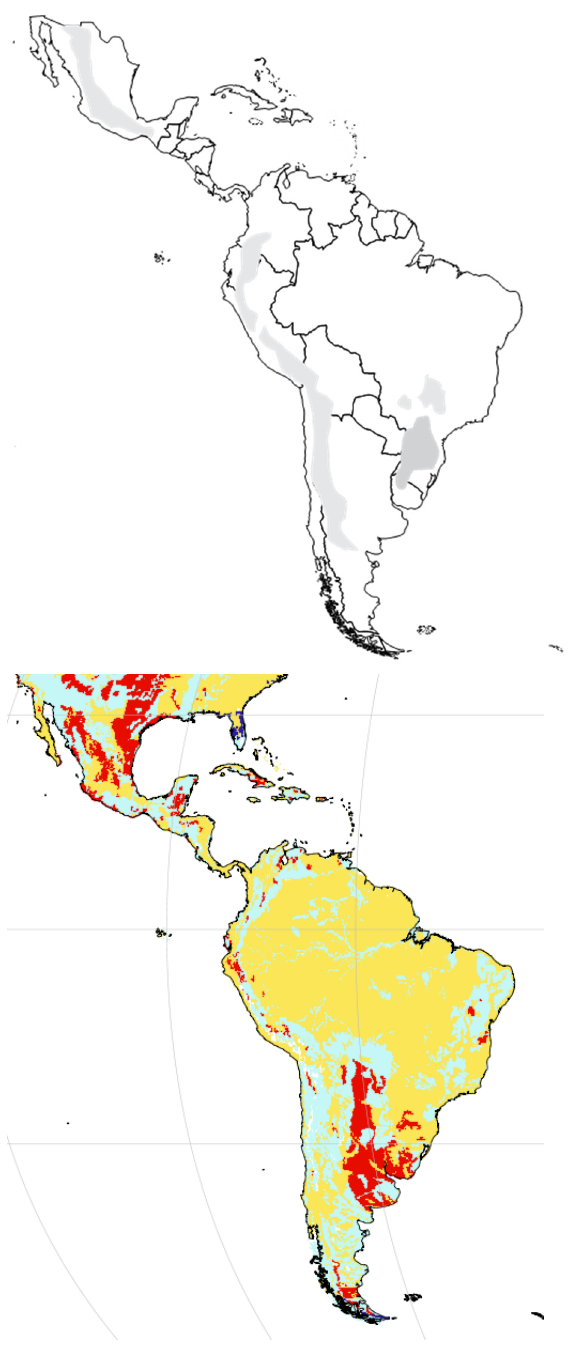
Figure 5. Localization of natural pozzolans (top; grey: volcanic rocks) and types of clay in the soil (0.3 ‐ 2 m depth) (bottom; light ‐ blue: illite, yellow: kaolinite, red: smectite) in LAC (adapted from [51] and